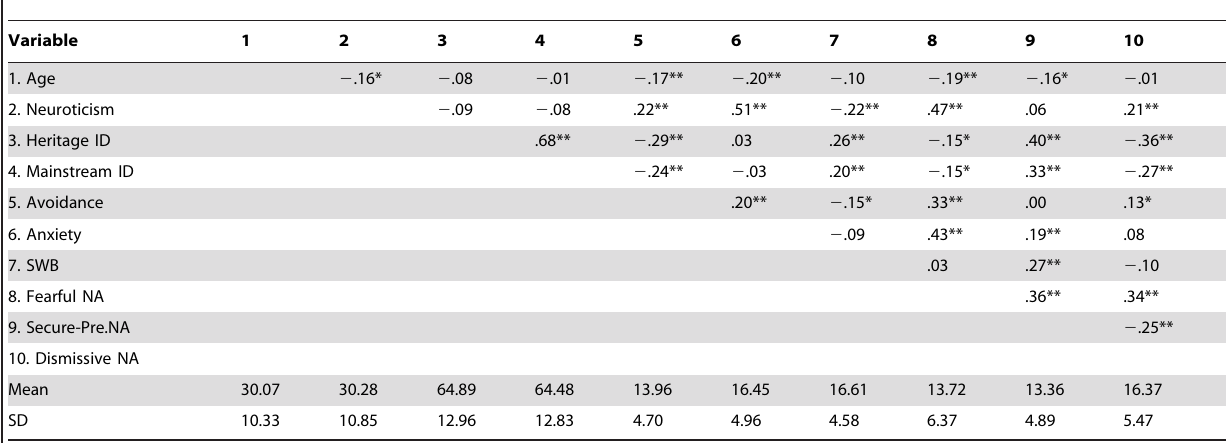
Table 2. Correlation Matrix between Variables.